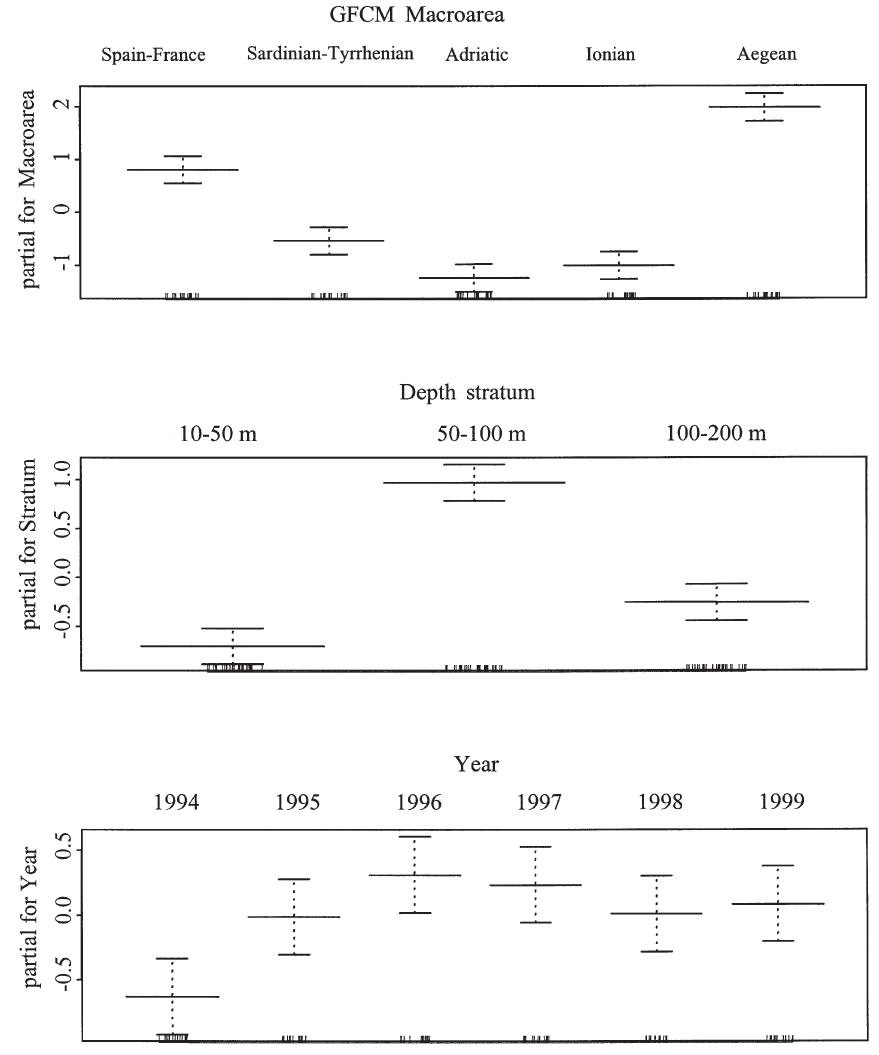
F IG . 1. – Results of the main effects of the model fitted to Citharus linguatula biomass indices, incorporating logarithmic link and gamma variance functions. Each plot represents the contribution of the corresponding variable to the fitted linear predictor: macro-area (above), depth stratum (centre) and year (below). The fitted values are adjusted to average zero; broken vertical bars indicate standard errors. The width of the solid bars at the base of the plots is proportional to the number of observations at each level of the factors.